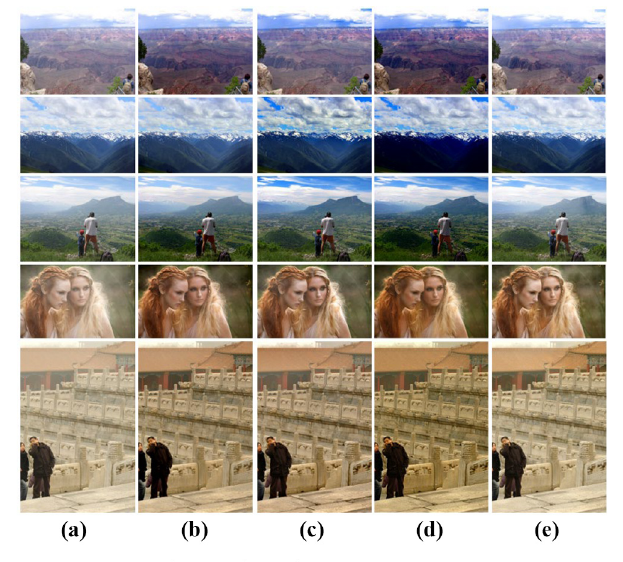
Figure 6. Dehazing results evaluated on real- world